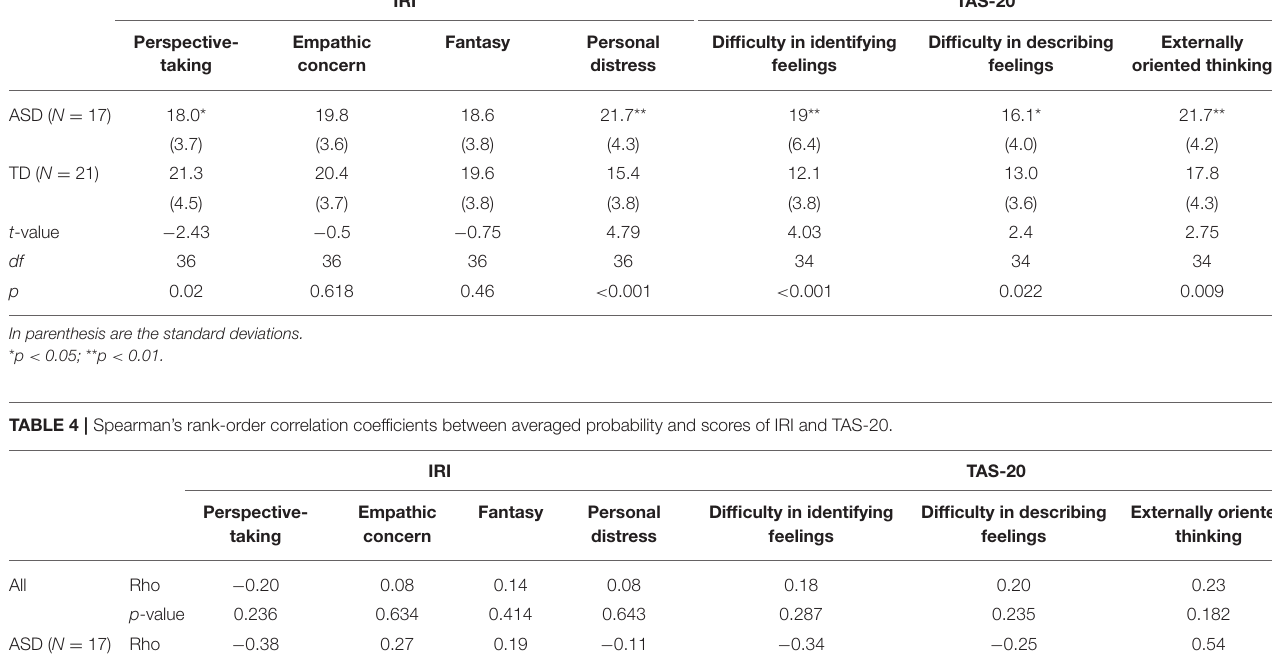
TABLE 3 | Mean and standard deviation of IRI and TAS-20 scores in each group, and the results of group comparison of each score by two-tailed t -test. IRI TAS-20 Perspective- Fantasy taking